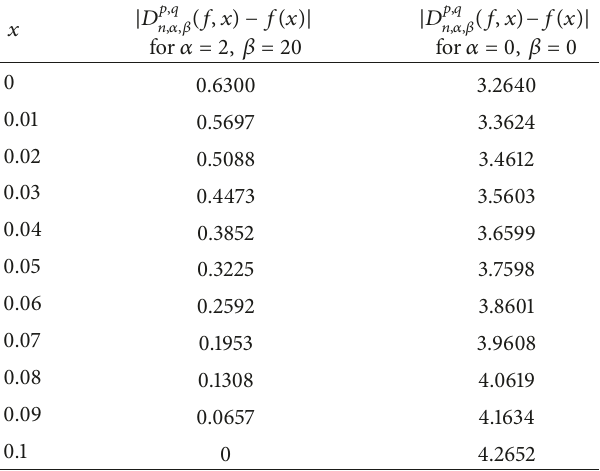
Table 1: Error of